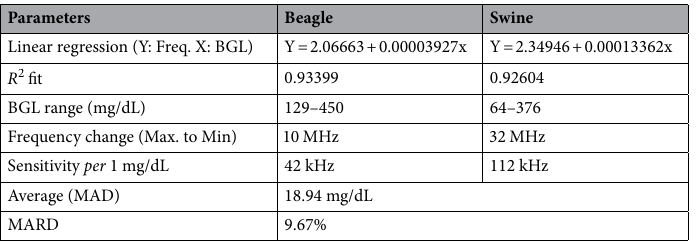
Table 1. IVGTT result